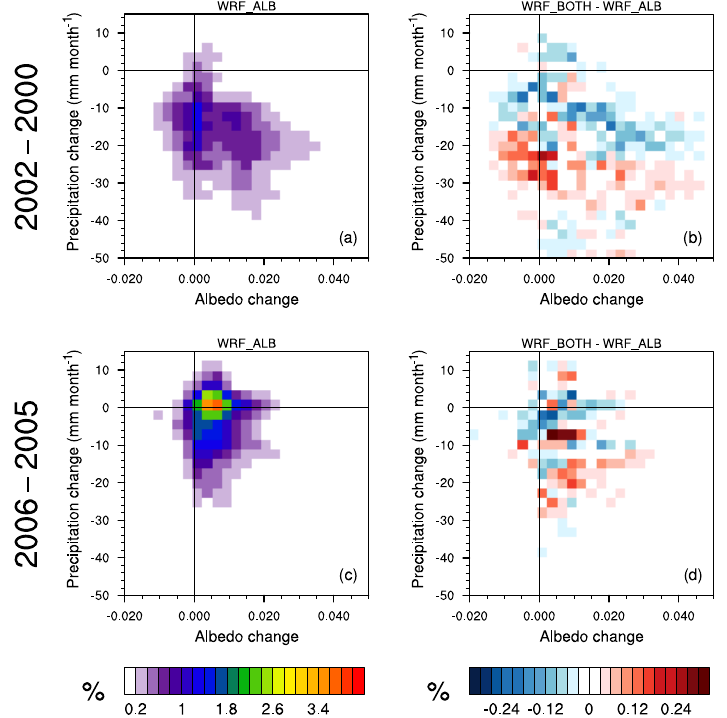
Figure 10. The bivariate joint probability distribution of the albedo change and precipitation change in the (a) 2002 drought (2002–2000) and (c) the 2006 drought (2006–2005). The change to this relationship caused by the addition of vegetation changes in the WRF_BOTH experiment is shown in (b) and (d) ,